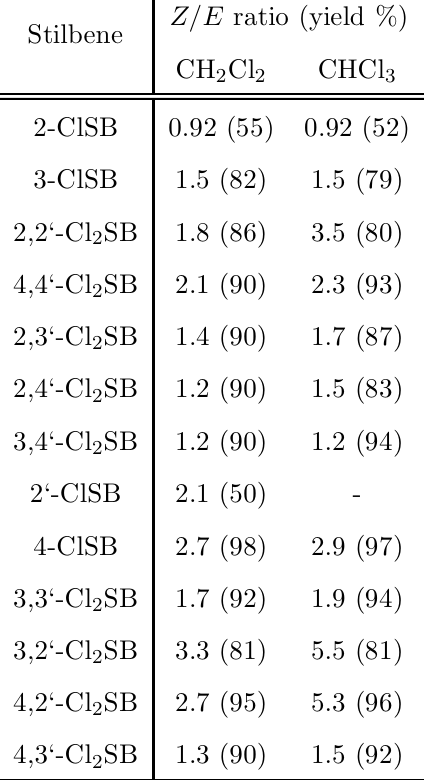
Table 3 The substituent e¬ect upon the Z=E ratio of stilbene